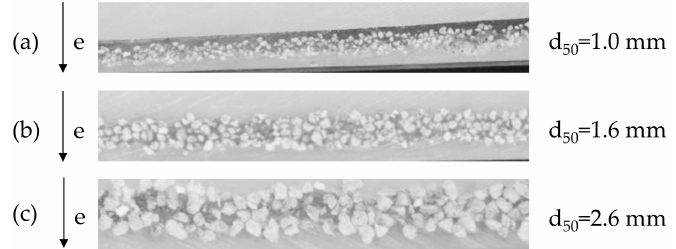
Figure A4. Cross section through three samples with ( a ) fine, ( b ) medium and ( c ) coarse grain size d 50 vertically penetrated with cement paste (dark grey areas); e: direction of